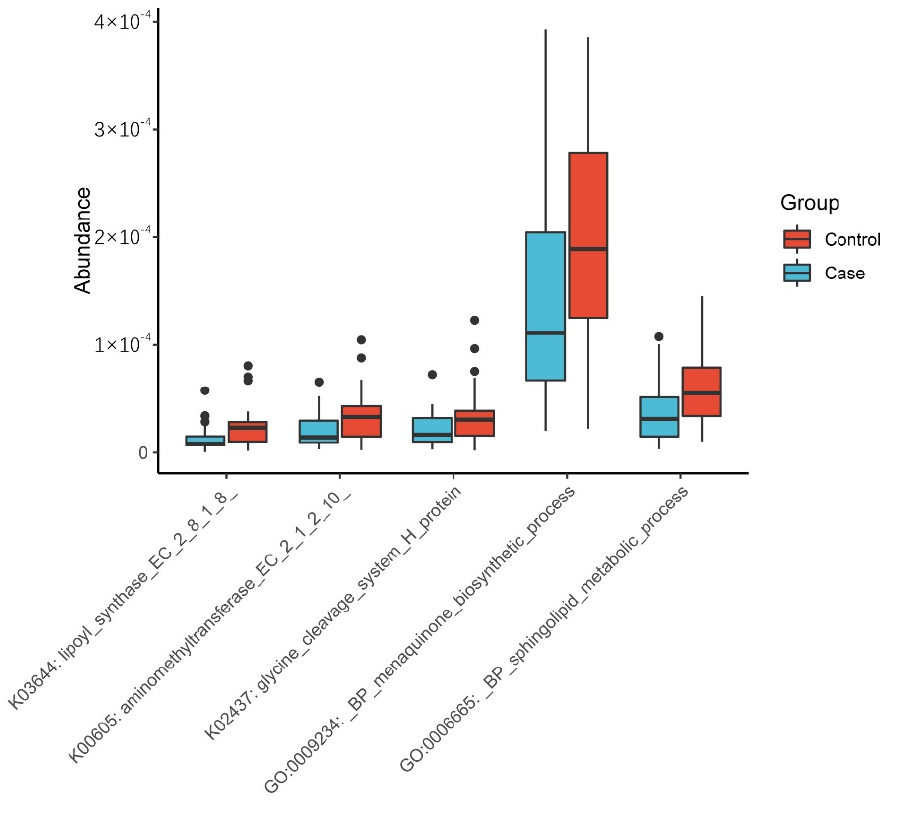
Figure 4. Boxplot of different function modules in two groups.